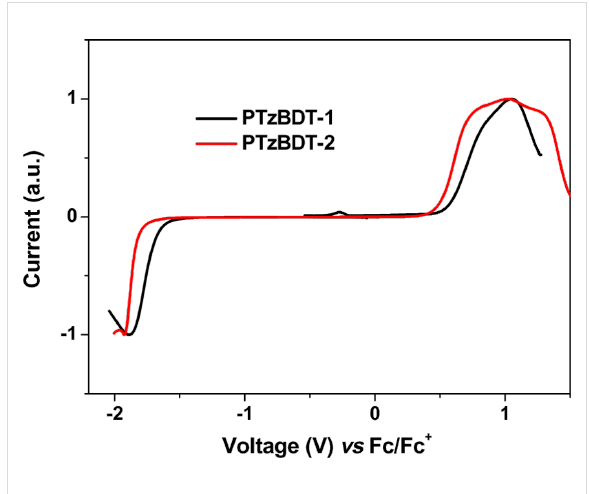
Figure 2: Square wave voltamogramme of PTzBDT-1 and